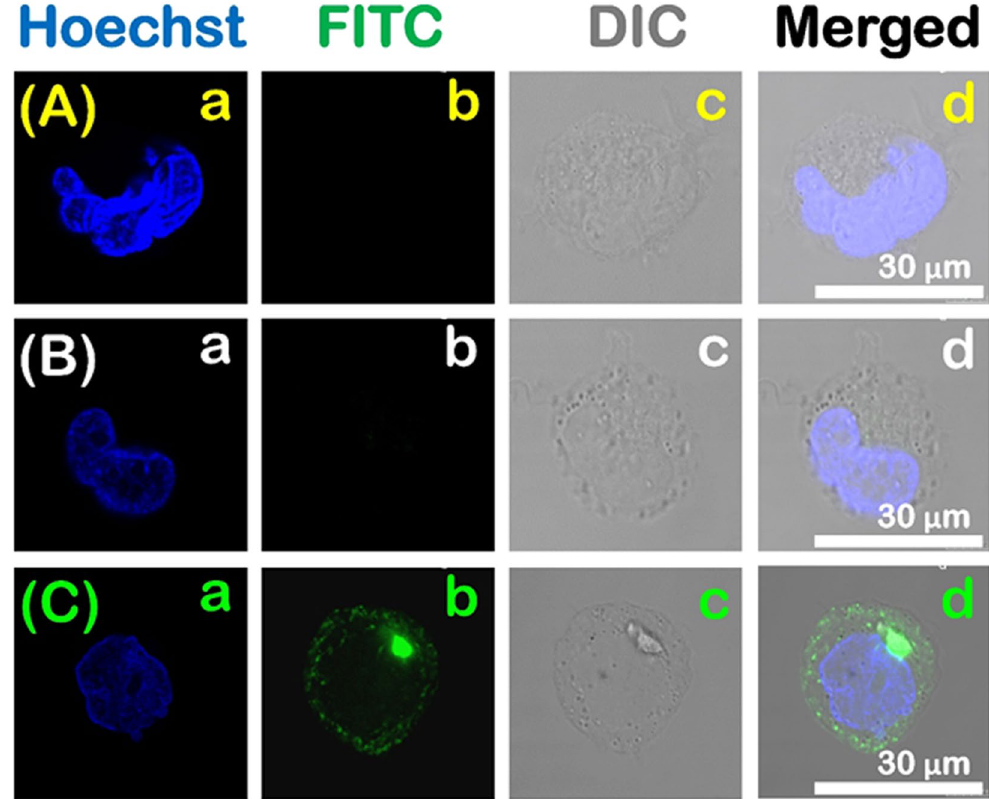
Figure 4. Confocal laser scanning microscopy images of the cellular uptake by THP-1 differentiated macrophages: the control ( A ), soluble FITC-OVA ( B ) and FITC-OVA-Cu-AMSs ( C )